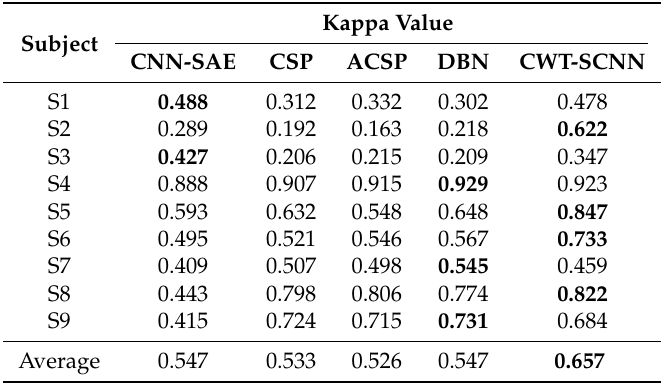
Table 3. The kappa values for five